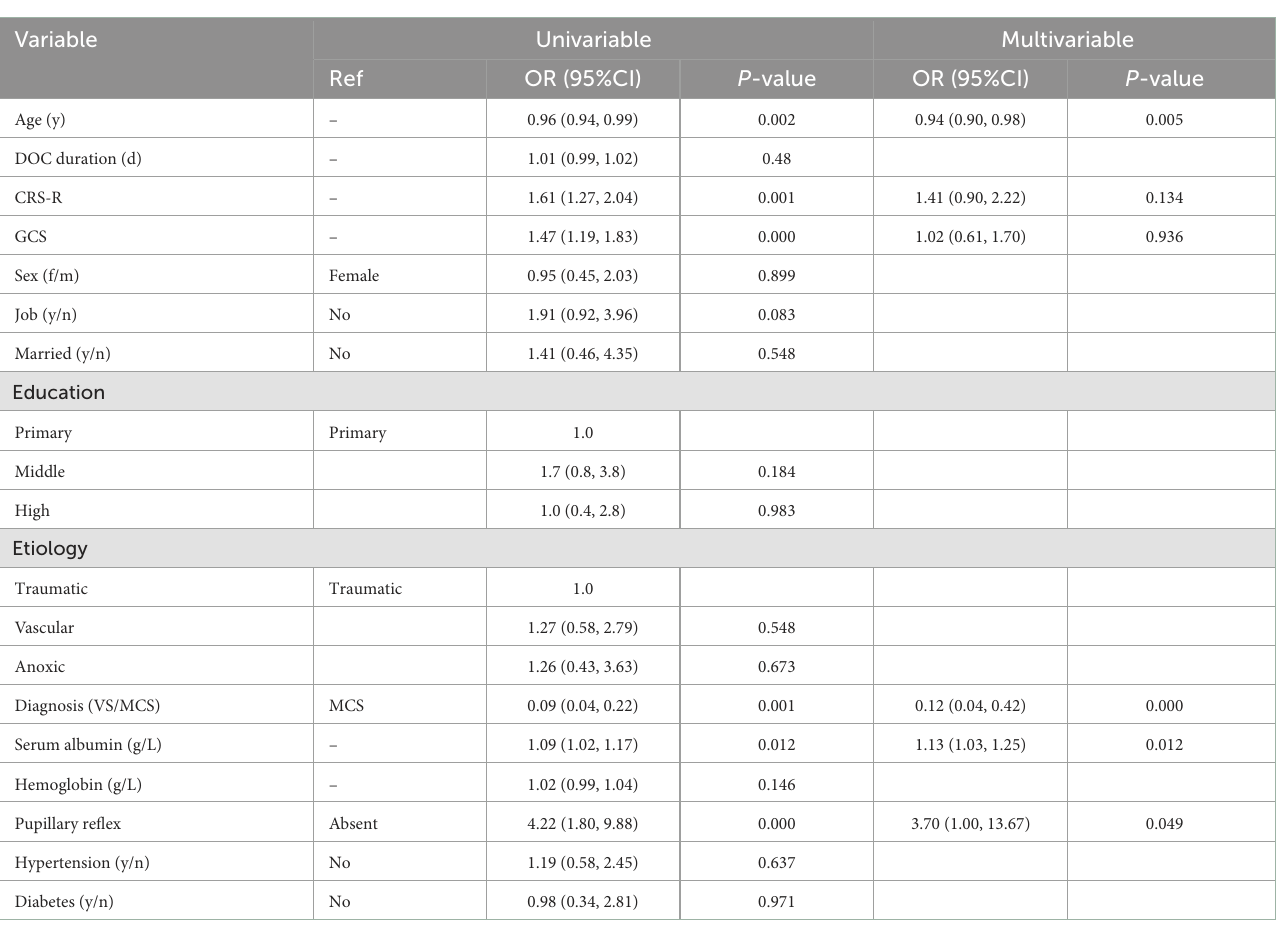
TABLE 2 Univariate and multivariate logistic regression analyses.